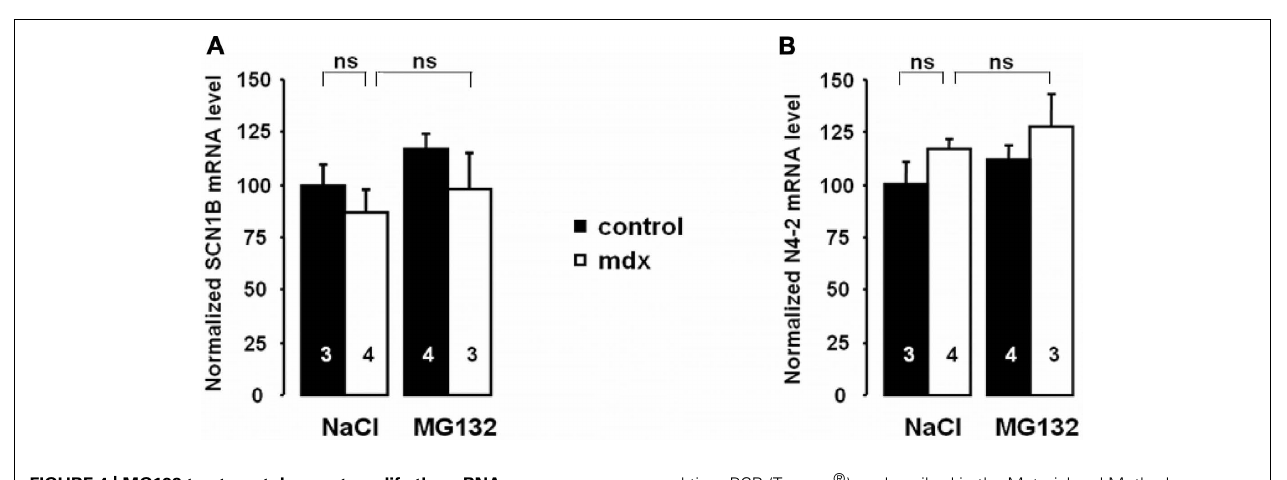
real time PCR (Taqman ® ) as described in the Material and Methods. The number of mice used for quantification is indicated in the bars. Results are expressed as normalized mean signal intensity. n.s. not